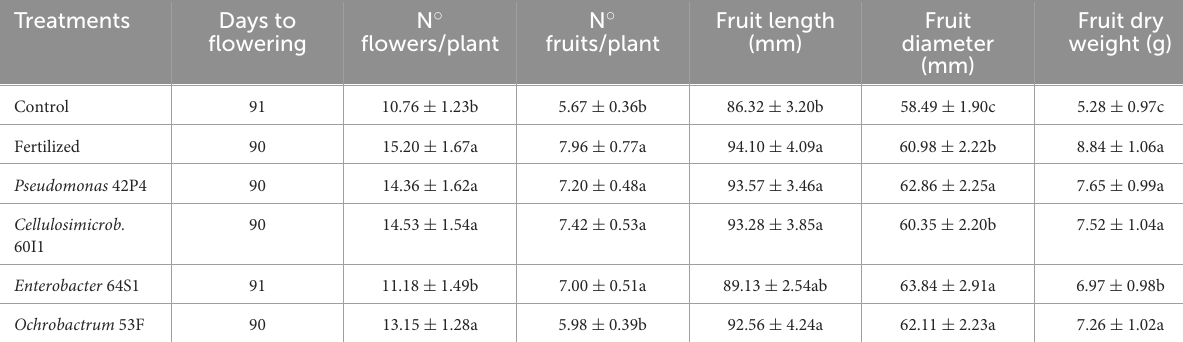
TABLE 2 Yield component parameters of pepper plants of 110 days-old. Treatments Days to N ◦ flowering